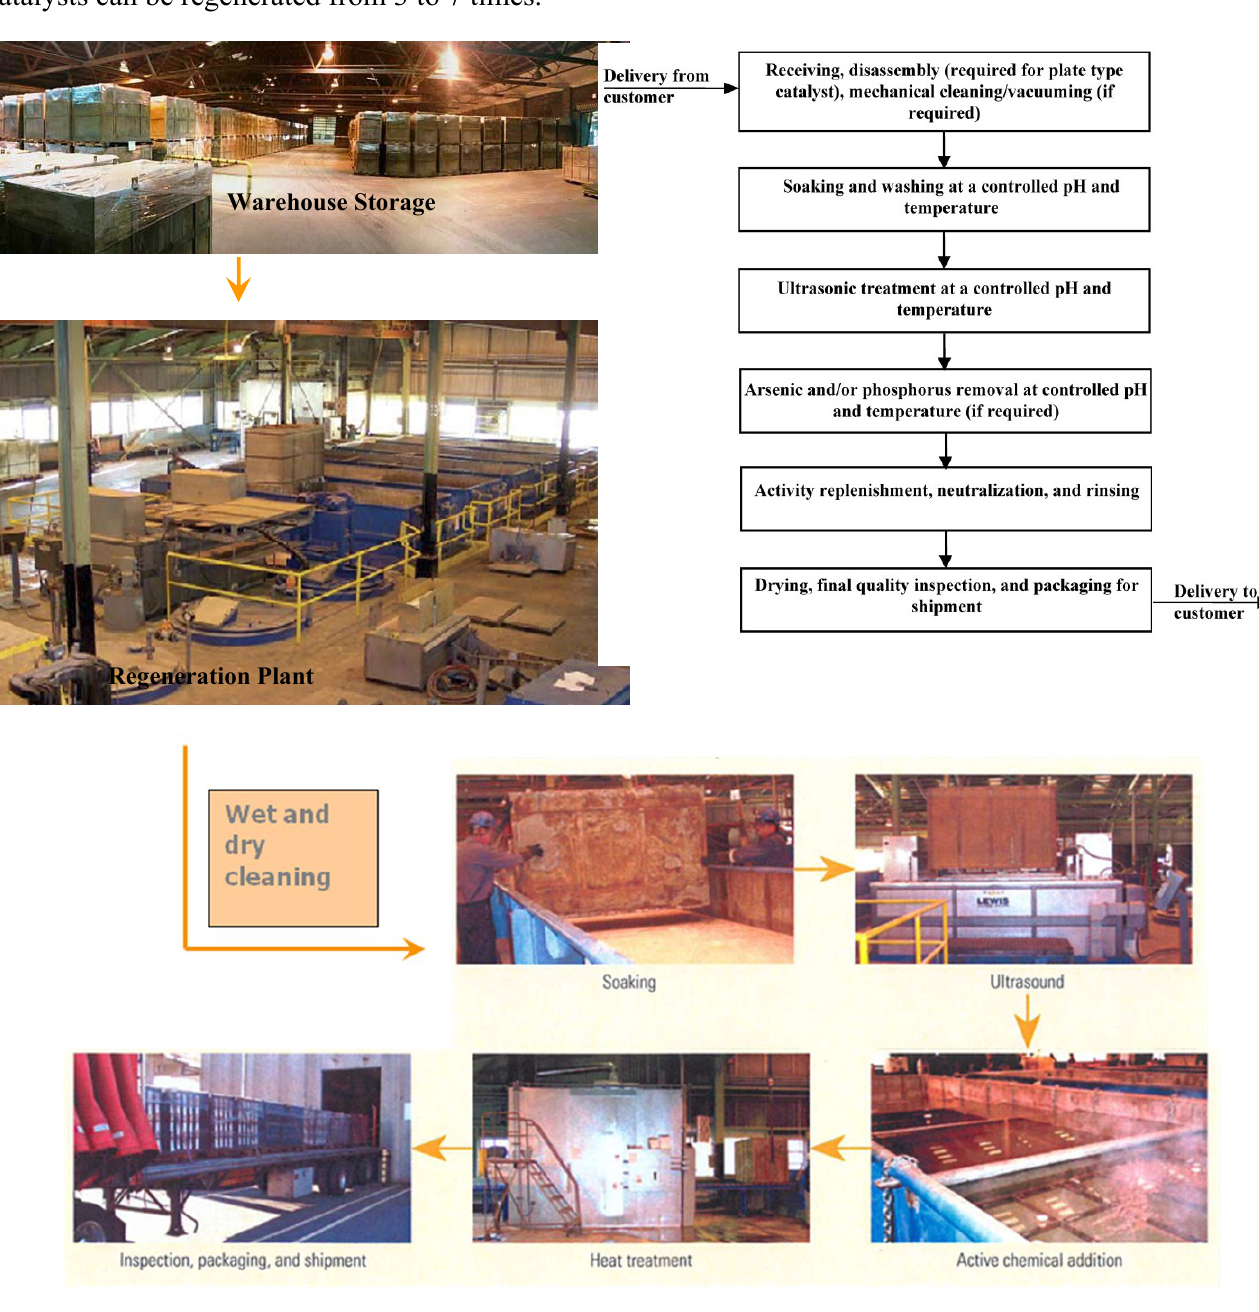
Figure 43. SCR-Tech catalyst regeneration process. Reproduced from [322,335–337]. Reproduced with permission of Electric Power and CoaLogix,